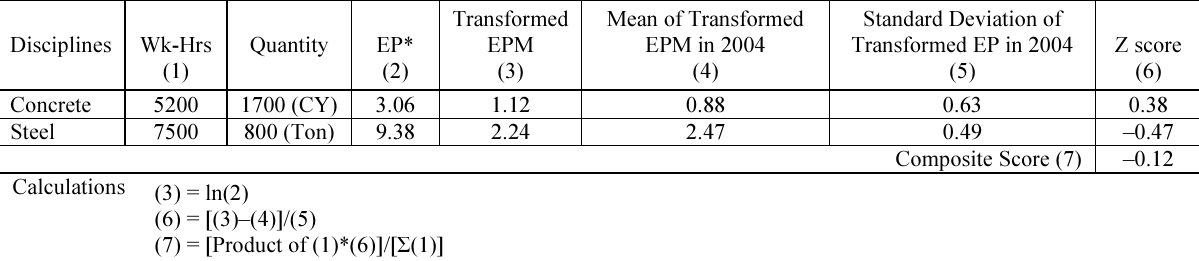
Table 3. A simplified Example using the Z-score Approach to Calculate the PEPM for a project